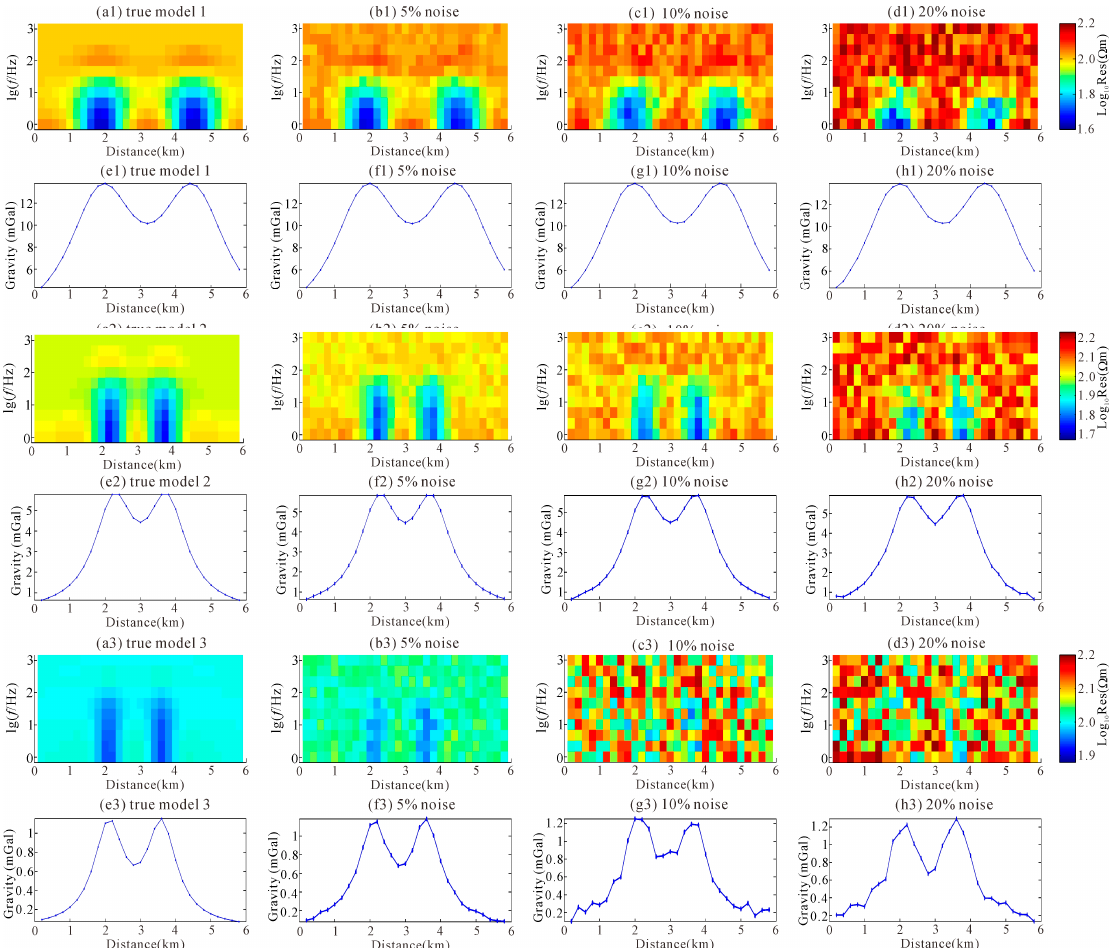
Figure 8. The model response results for three models of resistivity and density. The theoretical model responses of resistivity models obtained by TM mode ( a1 – a3 ); The theoretical model responses of density models ( e1 – e3 ); The resistivity model responses with 5% noise obtained by TM mode ( b1 – b3 ); The density model responses with 5% noise ( f1 – f3 ); The resistivity model responses with 10% noise obtained by TM mode ( c1 – c3 ); The density model responses with 5% noise. ( g1 – g3 ); The resistivity model responses with 20% noise obtained by TM mode ( d1 – d3 ); The density model responses with 20% noise ( h1 – h3 ).